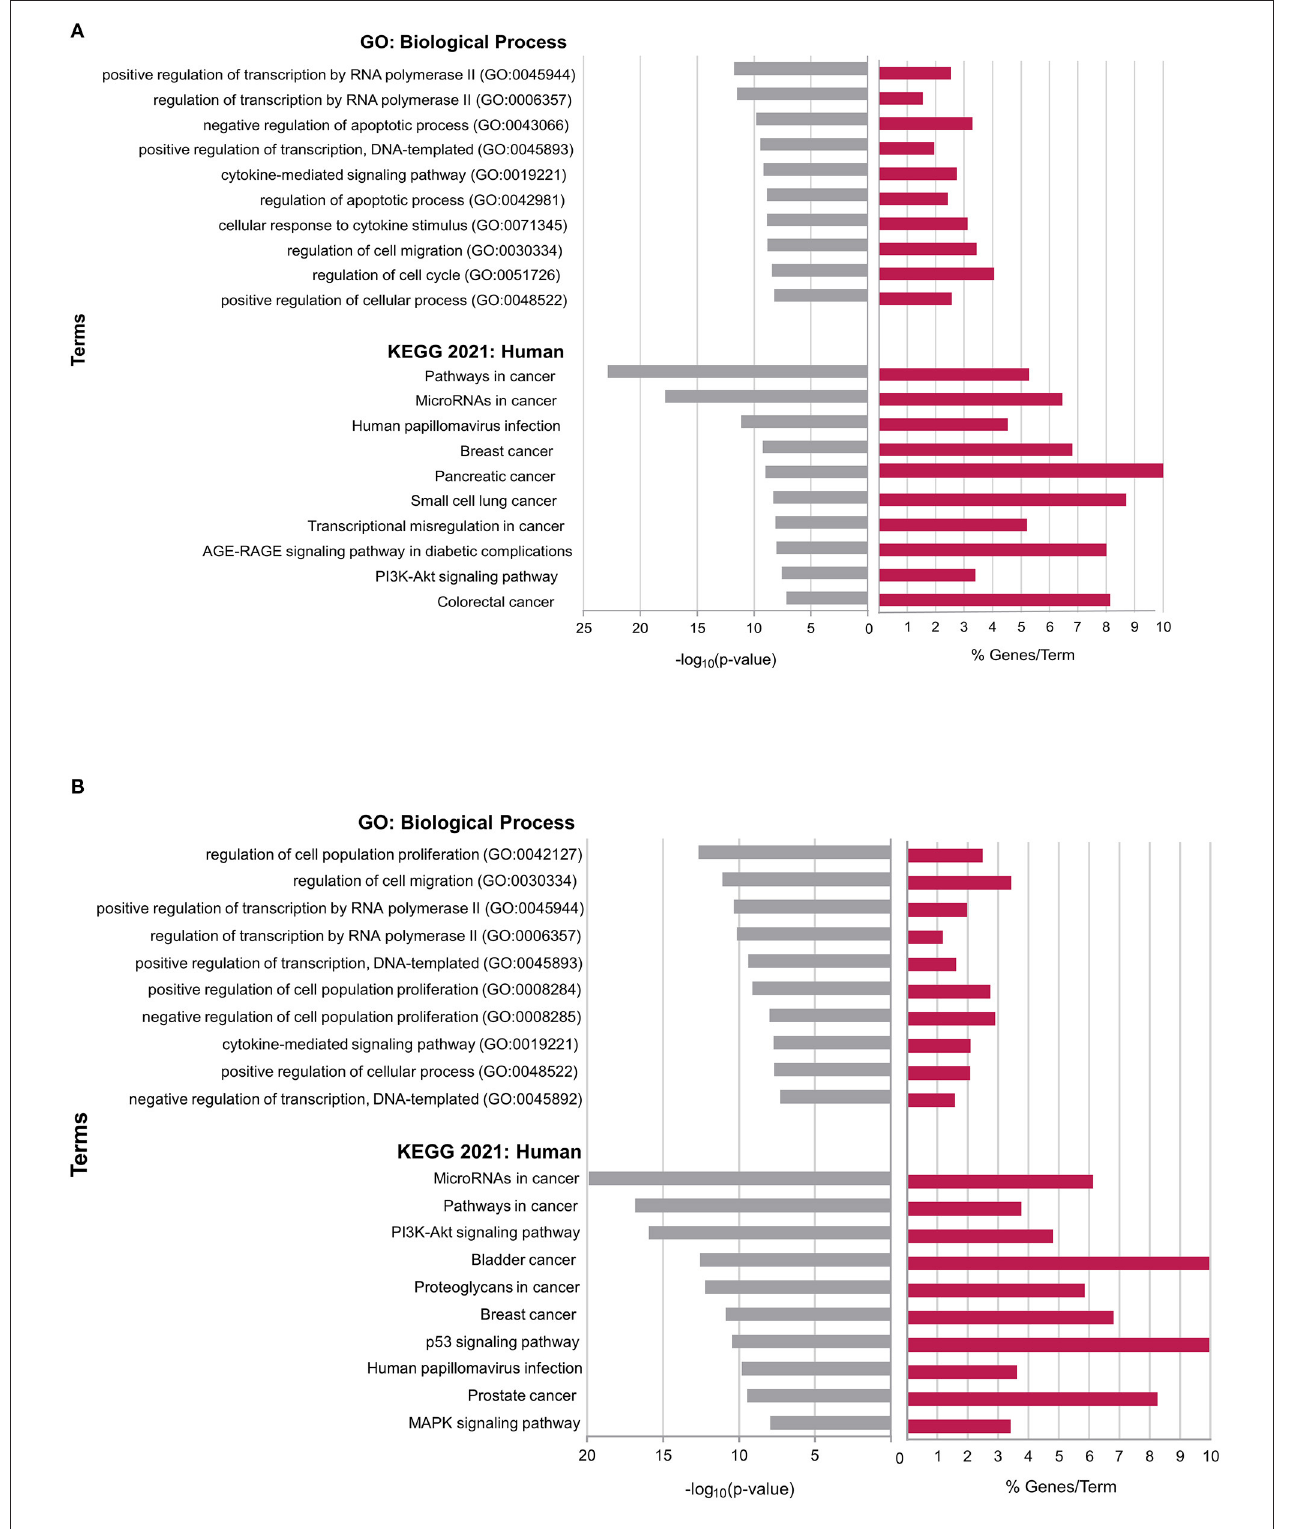
FIGURE 3 | (A,B) Functional classification of upregulated genes that are miRNA targets evaluated in LNCaP and PC-3 cells according to the EnrichR tool.